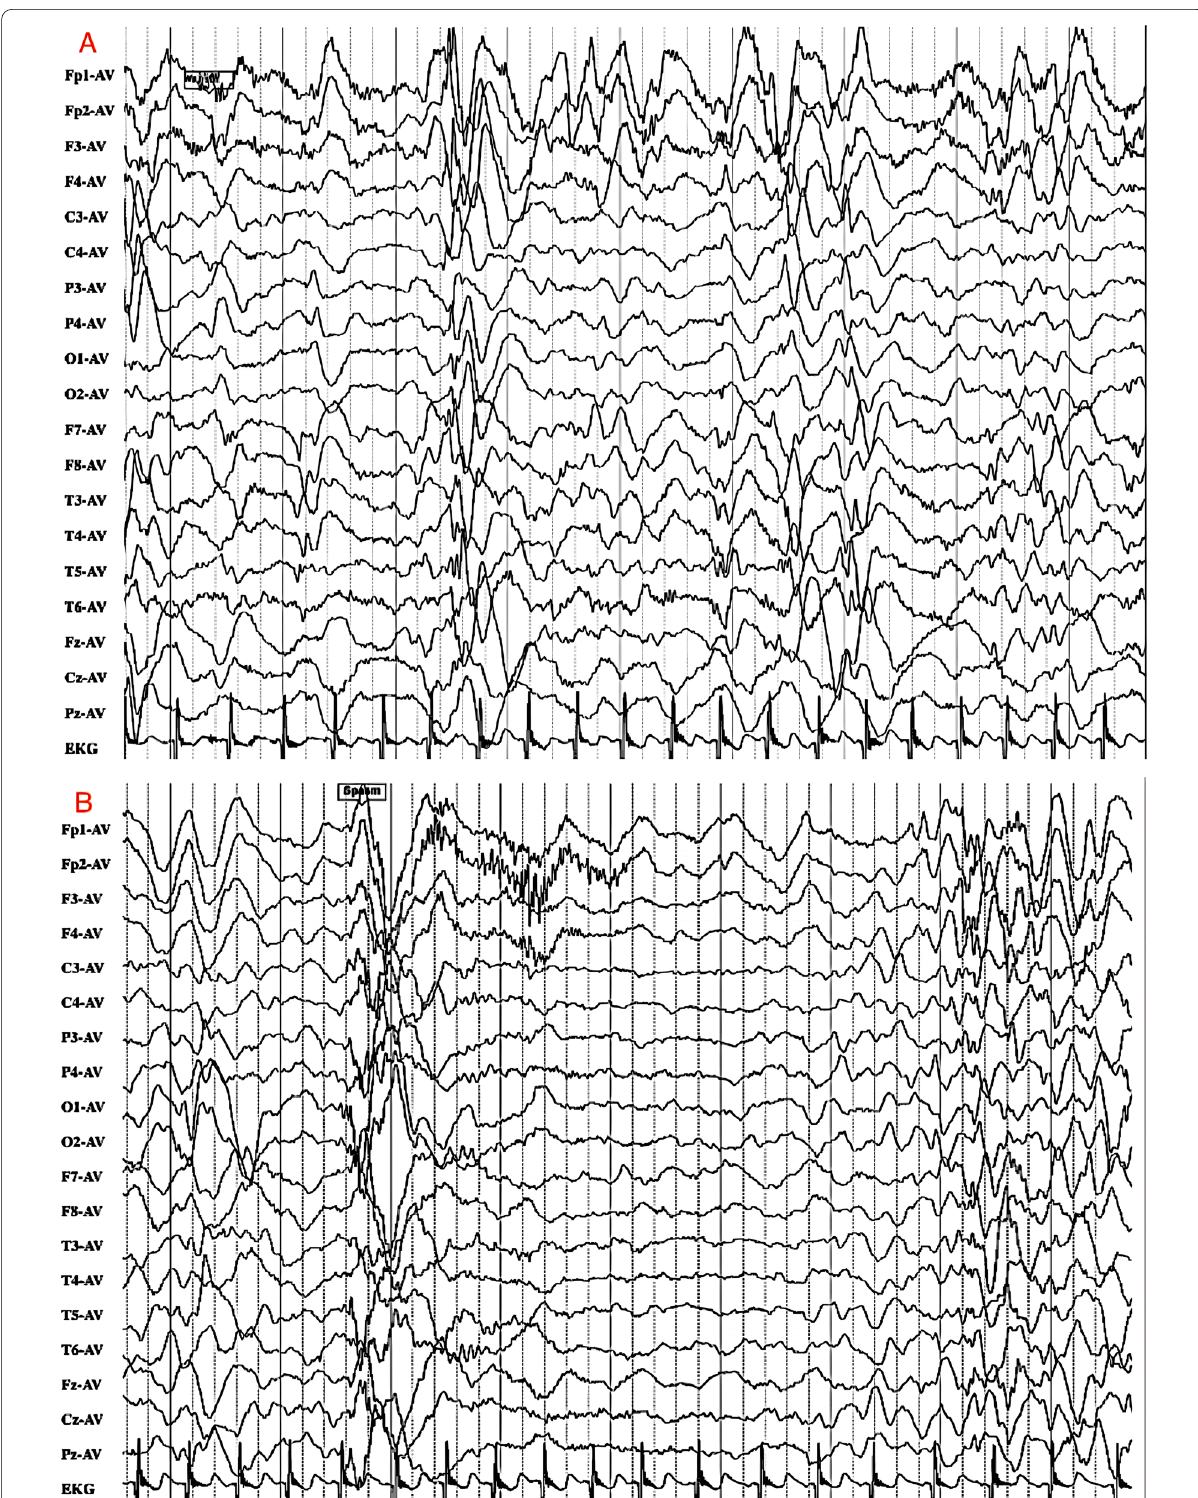
Fig. 1 Abnormal EEG at age of 6 months (on June 20, 2019). The background activity was completely disorganized and chaotic on interictal EEG, showing hypsarrhythmia. When the patient was awake, the susceptible ictal EEG showed flexor